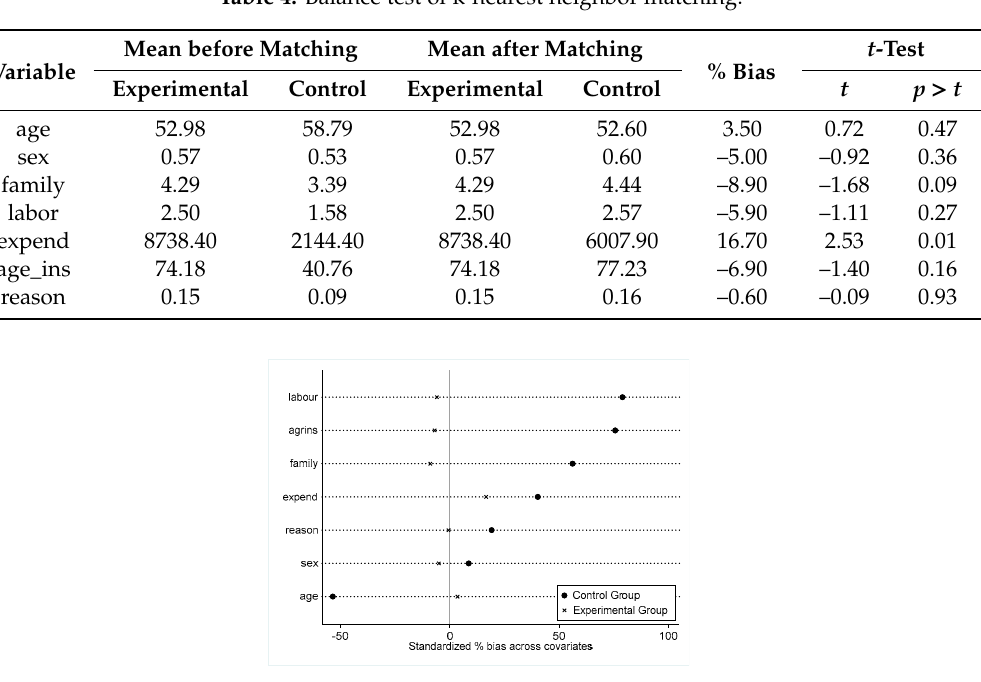
Table 4. Balance test of k-nearest neighbor matching.